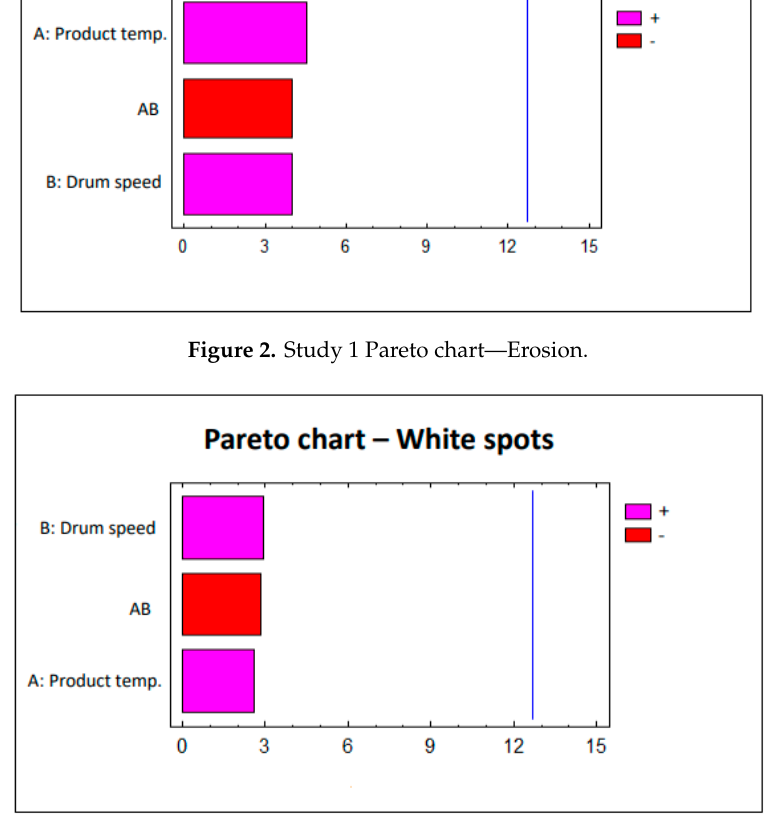
Figure 3. Study 1 Pareto chart—White spots.